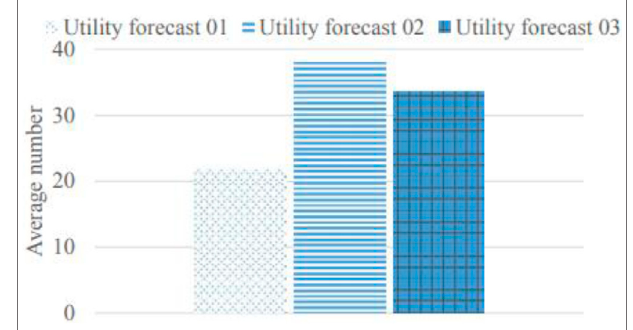
FIGURE 12 | Average number of times that the rescheduled forecast higher than utility